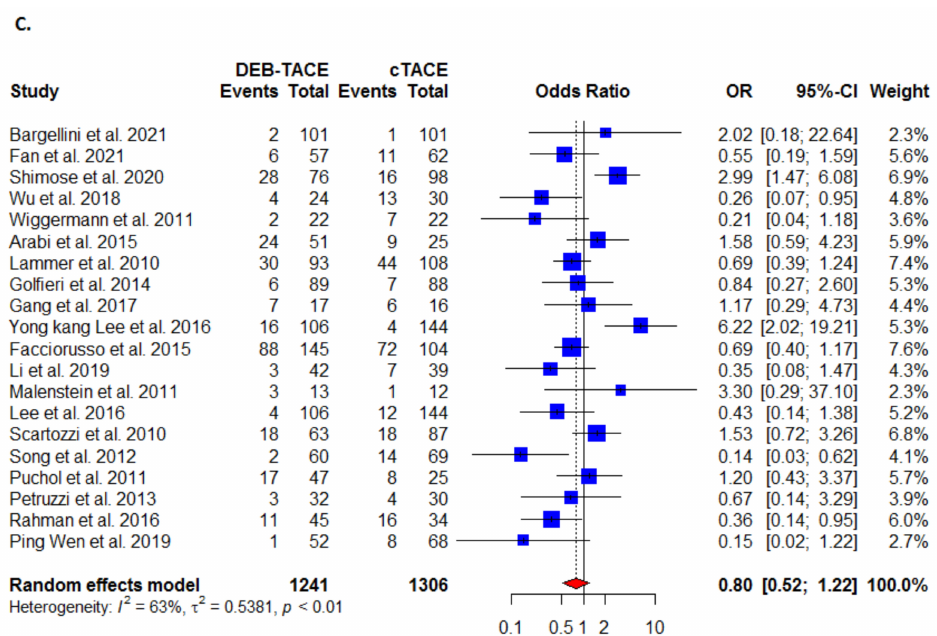
Figure 3. Forest plots for ( A ) disease stability; ( B ) disease control; ( C ) disease progression analysis between DEB-TACE (experimental) and C-TACE (control) treatment in patients with hepatocellular